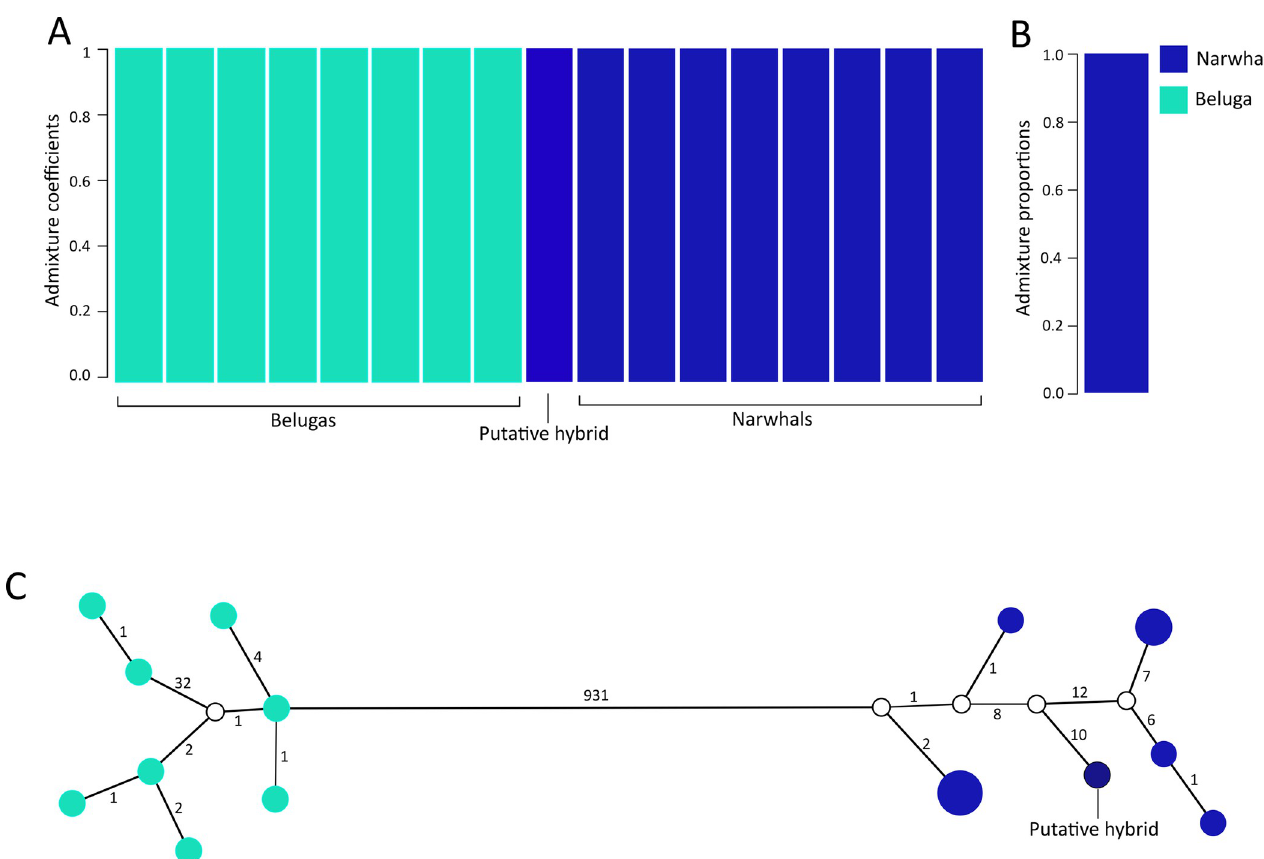
Fig 8. Ancestry analyses of NHMD 1963.44.1.4. ( A) NGSadmix analysis of the putative hybrid and a reference panel of eight narwhal and eight beluga individuals. ( B) fastNGSadmix analysis of the putative hybrid. ( C) mitochondrial haplotype network. Circle size indicates relative number of individuals sharing a haplotype. Belugas are indicated in light blue, narwhals are indicated in dark blue. The putative hybrid (NHMD 1963.44.1.4) appears as a narwhal in both genomic and mtDNA analyses. White circles indicate intermediate haplotypes not found in the samples. Numbers indicate mutation steps between haplotypes; of note, distances between haplotypes are not to